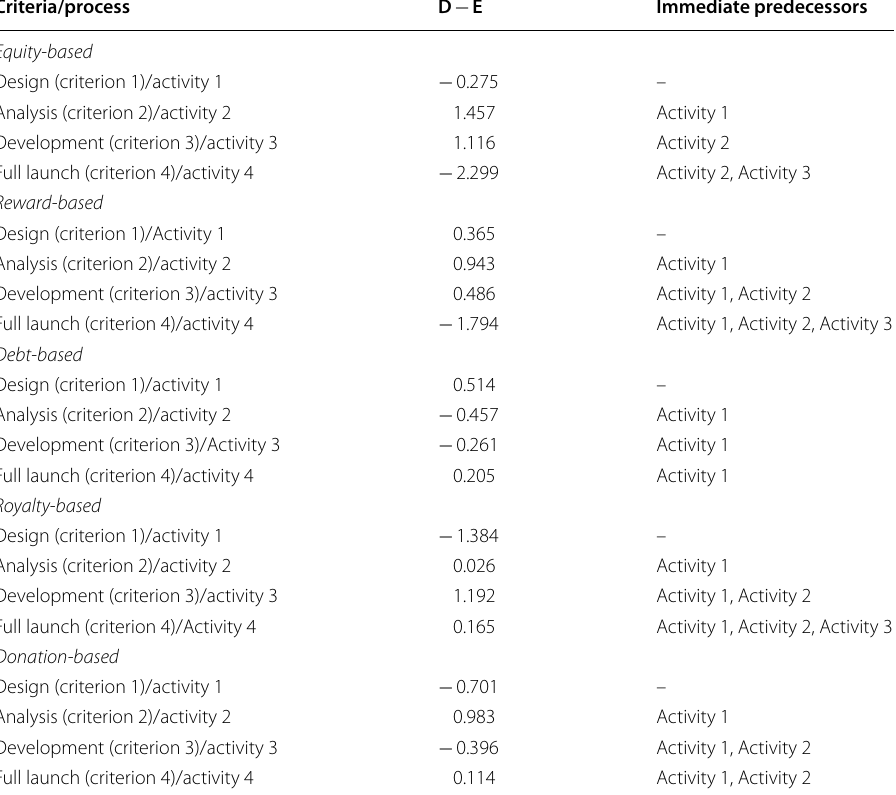
Table 21 Immediate predecessors of the service development process by the